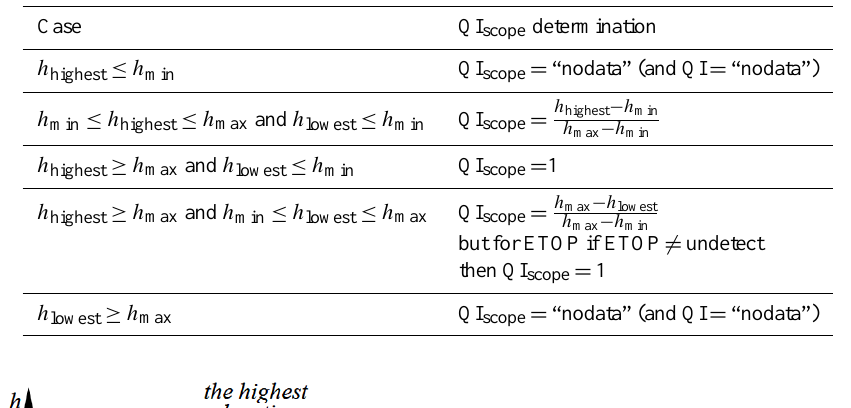
Table 2. Scheme of algorithm for QI Xscope determination.